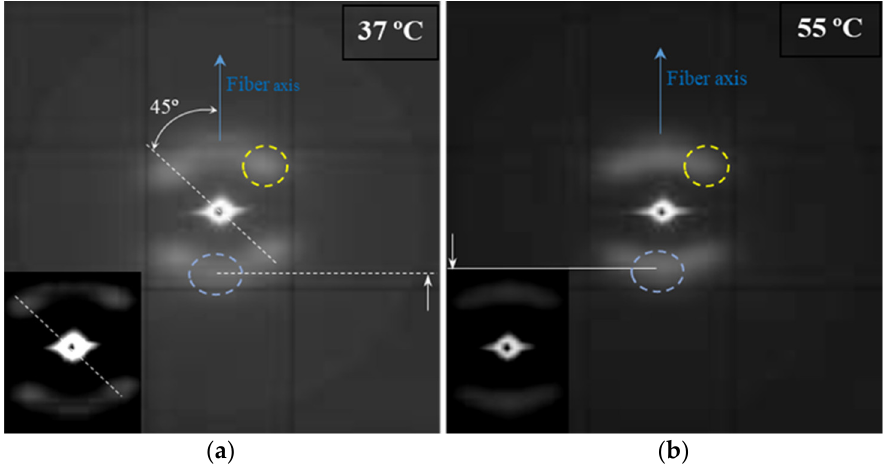
Figure 7. The SAXS patterns of an annealed suture submitted to low (i.e., pH 10, 37 °C, 27 days) ( a ) and high (i.e., pH 3, 55 °C, 27 days) ( b ) degradation processes. Insets show low contrast exposures of the corresponding patterns. Meridional and off meridional reflections are indicated by the blue and yellow dashed circles, respectively. Solid and dashed white lines highlight the different positions of meridional reflections.